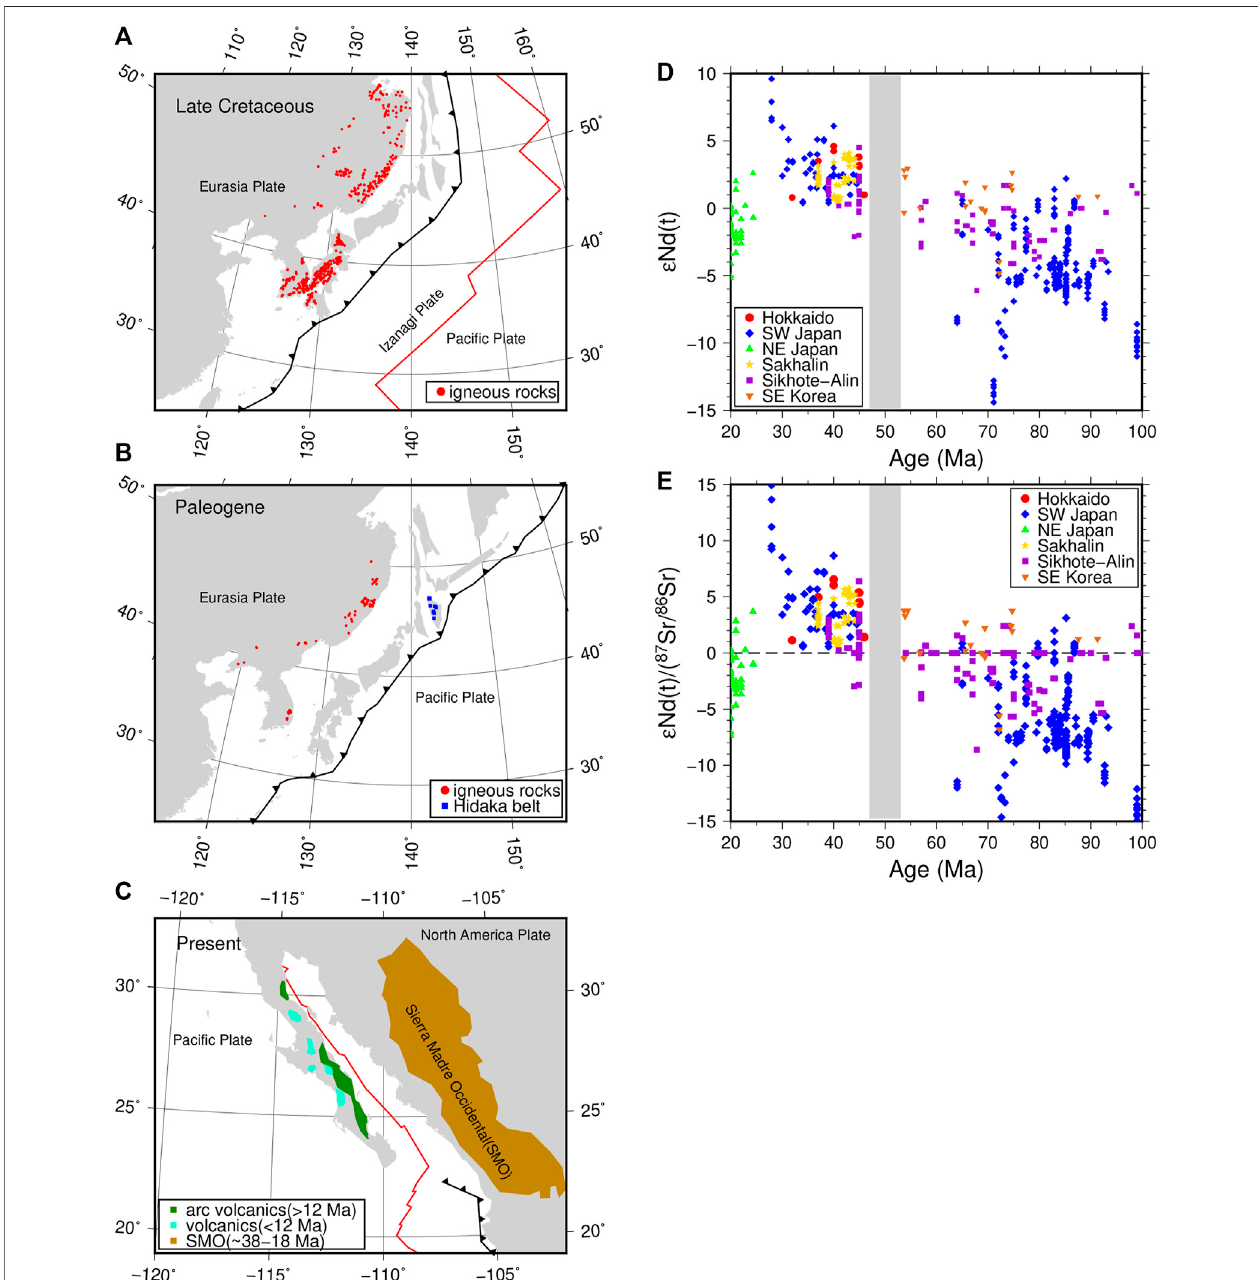
FIGURE 10 | Reconstructed model of the NE Eurasian plate and the West American plate and the ε Nd ( t ) and ε Nd ( t ) / ( 87 Sr / 86 Sr ) versus ages for the NE Eurasian igneous rocks. (A,B) show the distribution maps of igneous rocks in northeastern Eurasia during the Late Cretaceous and Paleogene, respectively. The red dots show the locations of igneous rocks. The blue squares show the Hidaka belt where MORB-type basaltic rocks are dominant (Nanayama et al., 2019). The black lines with trianglesarethe subduction zones at thattime.The red lineistheMOR between theIzanagi plate and thePaci fi cplate. (C) Locationsofthevolcanicrocks after the Oligocene and the Sierra Madre Occidental silicic large igneous province (Ferrari et al., 2018). Plate reconstruction topologies are derived from Müller et al. (2016) and Vaes et al. (2019). (D,E) show ε Nd ( t ) and ε Nd ( t ) / ( 87 Sr / 86 Sr ) values versus age for the northeast Eurasian igneous rocks from 100 to 20 Ma. The gray zone is a gap of continuous igneous events. Different color symbols [in (D,E) ] represent igneous rock samples in different regions. Igneous rock data are from Wu and Wu (2019) and Tang et al. (2018).